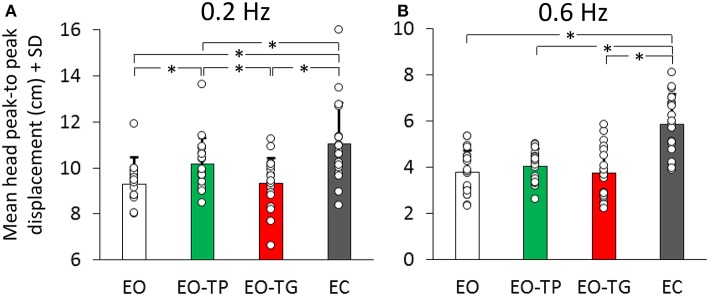
Mean head peak-to peak (P-P) displacement at 0.2 Hz (A) and at 0.6 Hz (B) translation frequency under the four visual conditions (EO: white bars, EO-TP: green bars, EO-TG: red bars and EC: gray bars). Each white dot superimposed to the bars corresponds to a subject. There was a significant difference in the mean P-P head oscillation across visual conditions. With EC, head P-P was the largest, while EO and EO-TG were the conditions in which the head P-P was the smallest. With EO-TP, head displacement was intermediate between EO and EC. Note the ordinate shift between the panels. In this and in the following Figures, the asterisk indicates a significant difference.